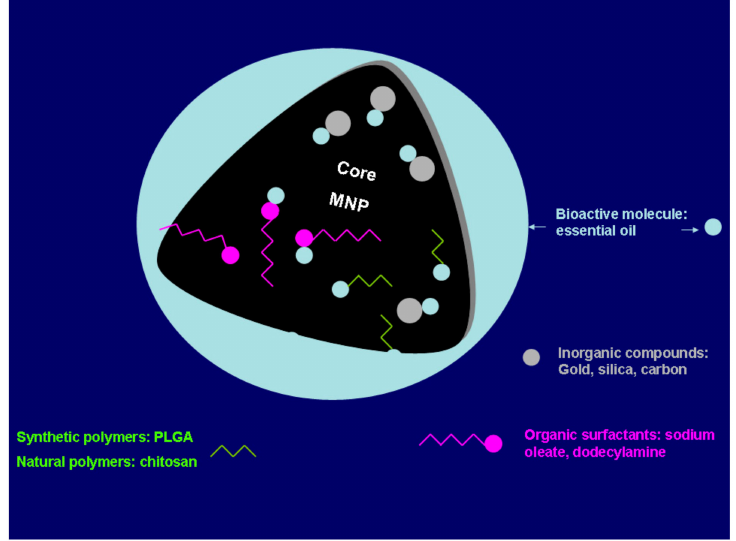
Figure 1. Schematic representation of the di ff erent strategies available to obtain water-soluble and chemically active nanoparticles. The final ligands on the nanoparticles can be either small molecules or polymers. (MNP—magnetic nanoparticles). Adapted from Wallyn et al.